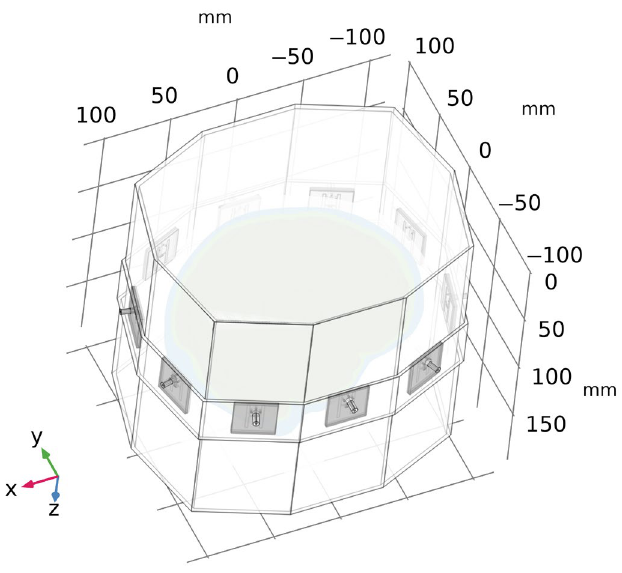
Figure 4. A geometry of a 3D numerical model of the laboratory prototype of microwave imaging system. For clarity, the air surrounding the antenna array is omitted in the figure.